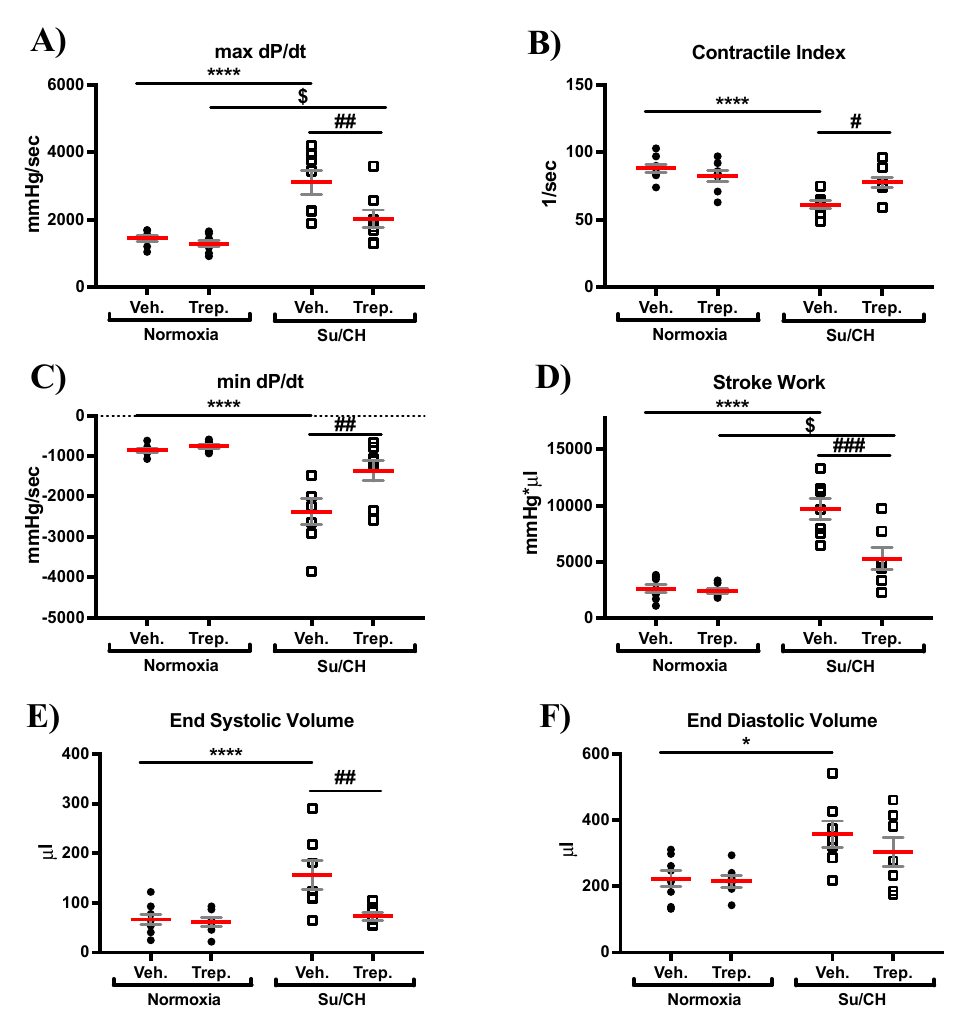
Figure 2. Development of right ventricular contractile dysfunction with SuCH and its attenuation with treprostinil treatment. Individual value grouped plots for ( A ) maximum rate of pressure change (max dp/dt), ( B ) contractile index, ( C ) minimum rate of pressure change (min dp/dt), ( D ) stroke work, ( E ) end-systolic volume, and ( F ) end-diastolic volume; n = 7–8 animals/experimental group; *, $, and # present significance vs. normoxia+Veh., normoxia+Trep., and SuCH+Veh., respectively; *, $, and # p ≤ 0.05; ## p ≤ 0.01; ### p ≤ 0.001; **** p ≤ 0.0001.